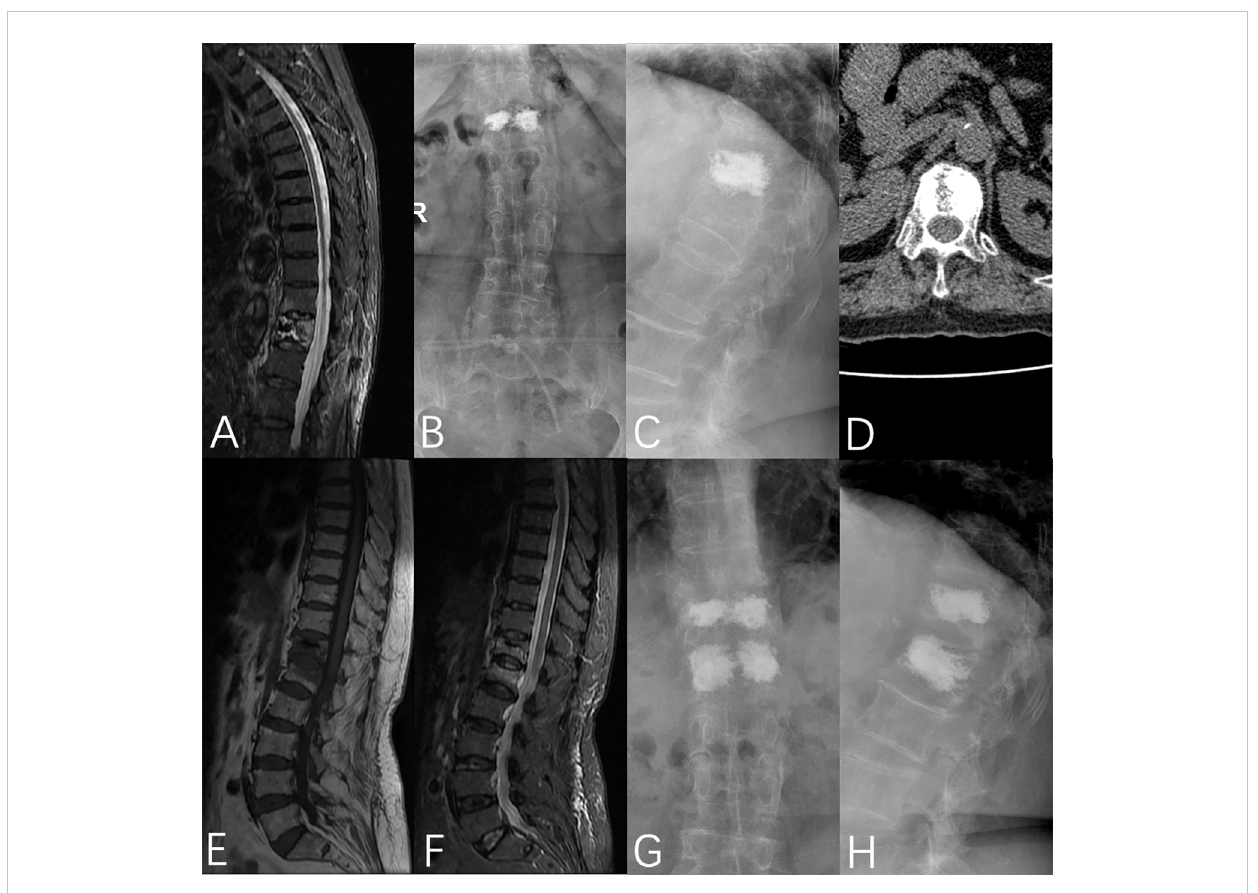
FIGURE 6 A 76-year-old female was admitted to the hospital with no obvious cause of low back pain for 1 week, was diagnosed with OVCF (T12), and underwent PVP under local anesthesia on the third day after admission. (A) Preoperative fat-suppressed image showed T12 vertebral fracture, (B, C) T12 vertebral bone cement fi lling could be seen in the anterior and lateral X-rays after the operation, (D) Postoperative CT showed that the bone cement was unevenly distributed on the bilateral sides of the vertebrae, (E, F) MRI showed L1 vertebral fracture 5 months after the operation, (G, H) T12 and L1 vertebral bodies were fi lled with bone cement in the anterior and lateral X-rays after the